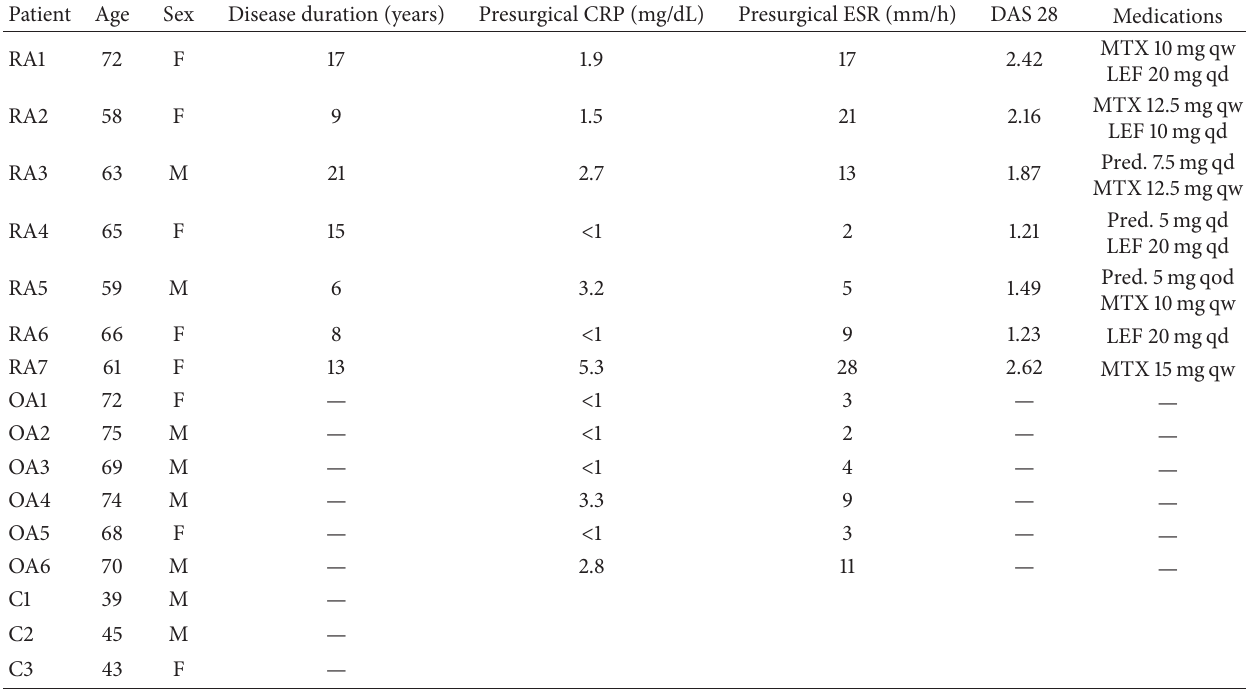
Table 1: Clinical characteristics of the patients ∗